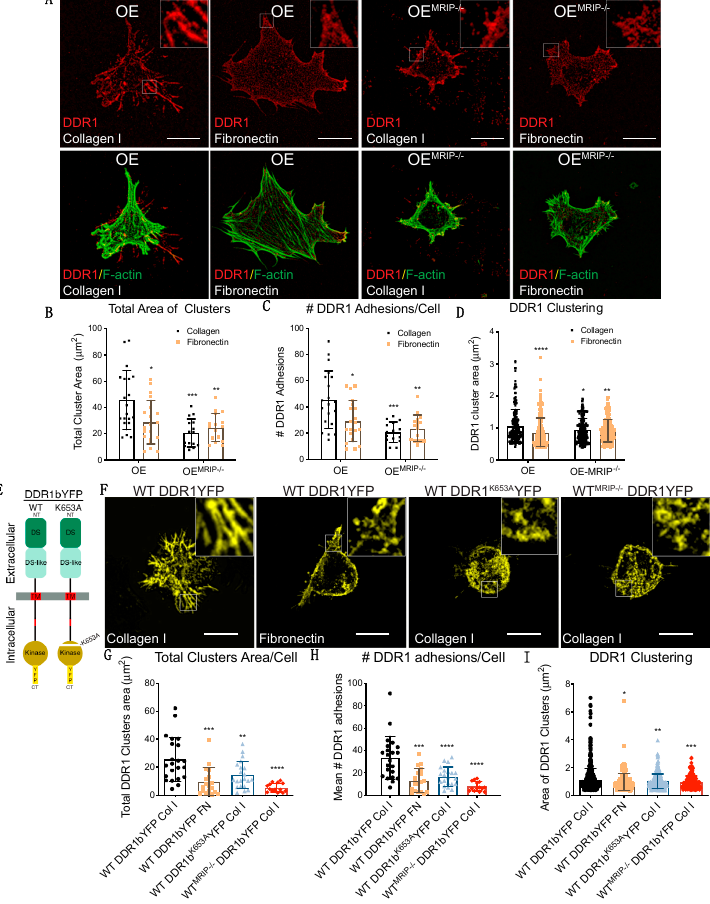
Figure 4. MRIP enables DDR1 cluster formation and growth. ( A ) Cells were cultured on fibrillar collagen films or on fibronectin for 8 h. An antibody against the extracellular N-terminal region of DDR1 (AF2396, R&D) was used to stain non-permeabilized preparations (top, red) followed by phalloidin to stain F-actin (bottom, green). Quantification of total cluster area, ( B ), number, ( C ), and single cluster area, ( D ), of DDR1 adhesions on collagen or on fibronectin using Fiji. Scale bar, 20 μ m. ( E and F ) GD25 WT or WT MRIP-/- cells were transfected with mouse DDR1b-YFP (full-length kinase- active isoform), or mouse DDR1b K653A -YFP and cultured on fibrillar collagen or on fibronectin as indicated. ( G – I ) Quantification of total cluster area, number, and single cluster area of DDR1b-YFP or DDR1b K653A -YFP adhesions on collagen or on fibronectin as indicated using Fiji. Data are reported as mean ± SD, n = 3. * p < 0.05, ** p < 0.005 *** p < 0.0005, **** p <0.0001. Scale bar, 20 μ m.